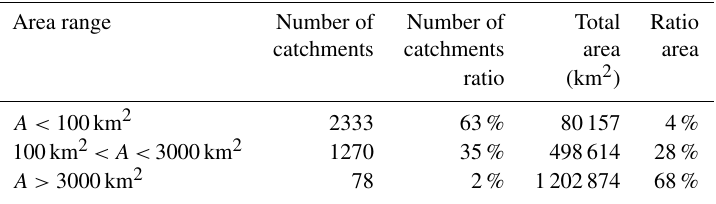
Table 1. Catchment distribution per area and ratio to total area. Area